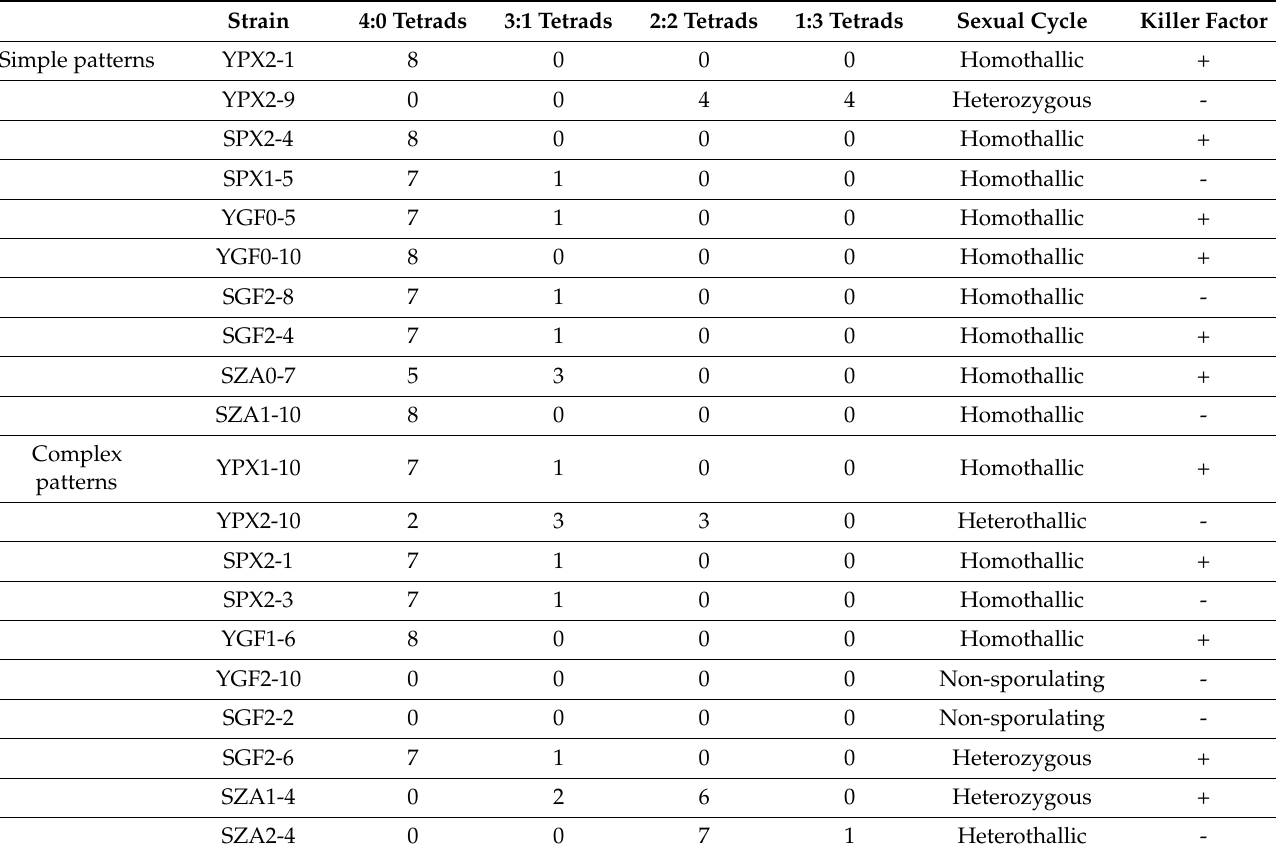
Table 2. Spore viability in dissected four spore’s asci (number of 4:0, 3:1, 2:2, 1:3 viable: non- viable segregating tetrads. No 0:4 segregations were obtained), sexual life cycle (homothallism- heterothallism), and killer factor of the indicated strains harbouring simple and complex microsatellite patterns (+, strain with killer phenotype; -, strain without killer